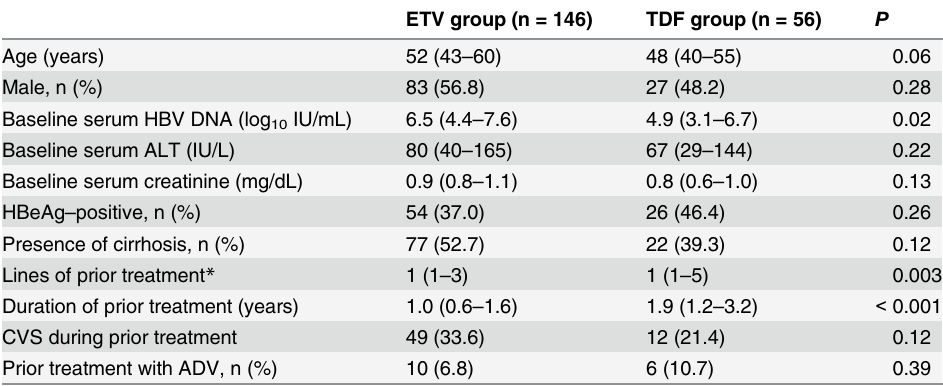
Table 1. Baseline characteristics by treatment